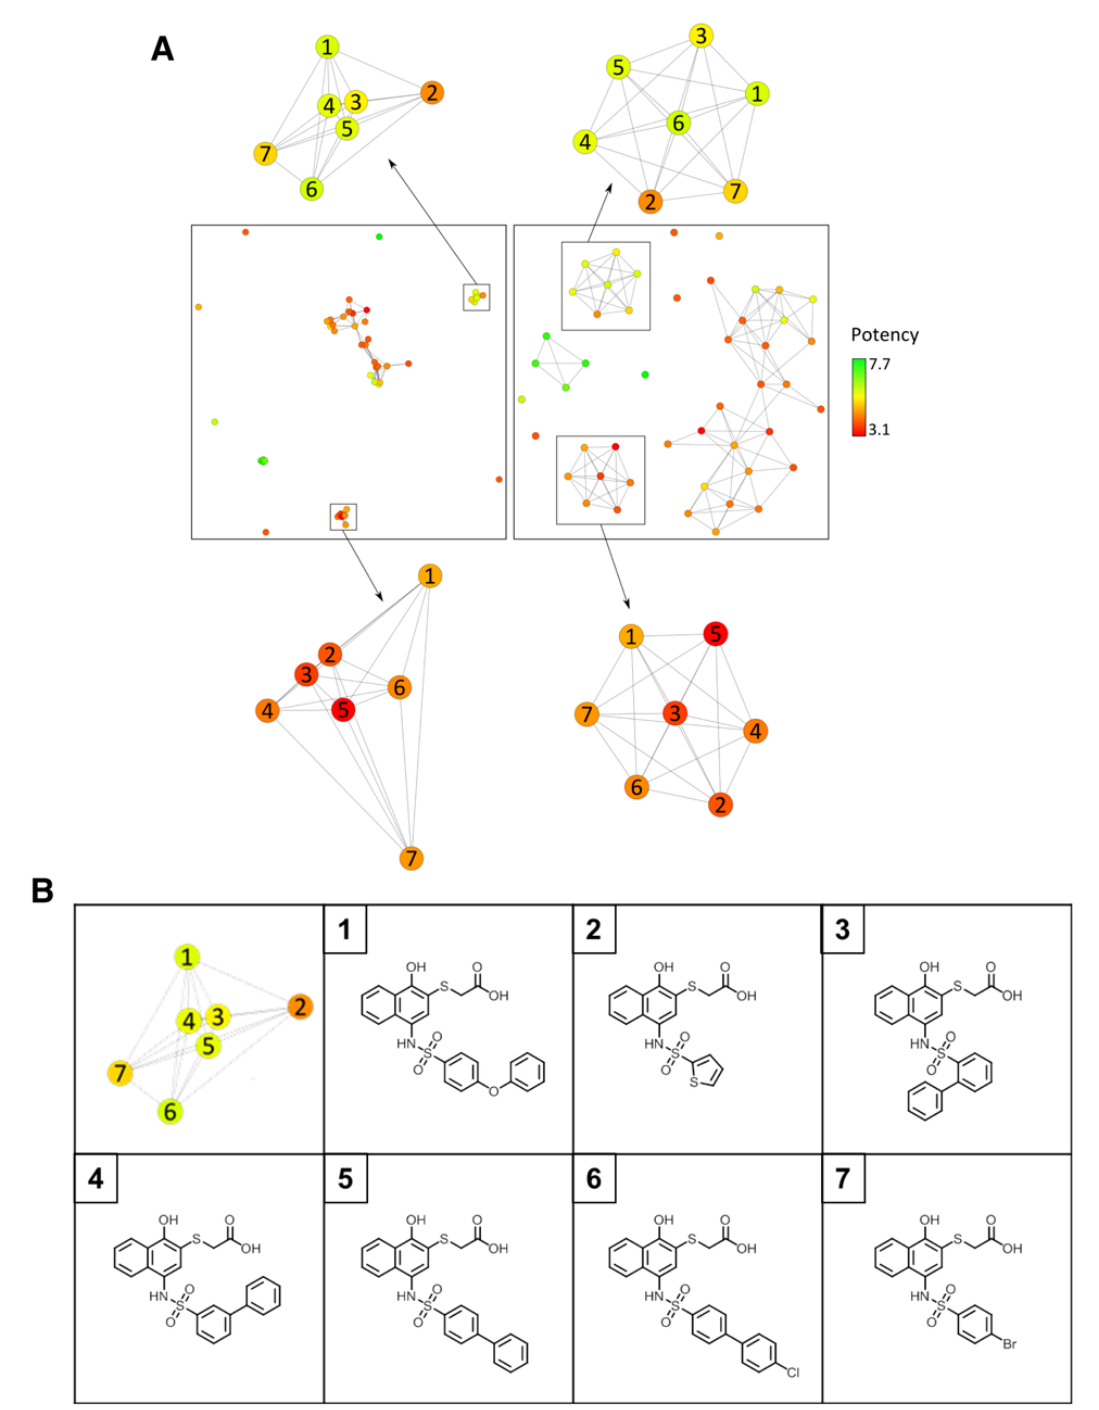
Figure 4. Comparison of compound communities. In ( a ), corresponding compound communities are highlighted in the KK and FR CSNs from Figure 3 and enlarged. Compounds in each community are numbered. In ( b ), compounds forming the top cluster in ( a ) are shown.